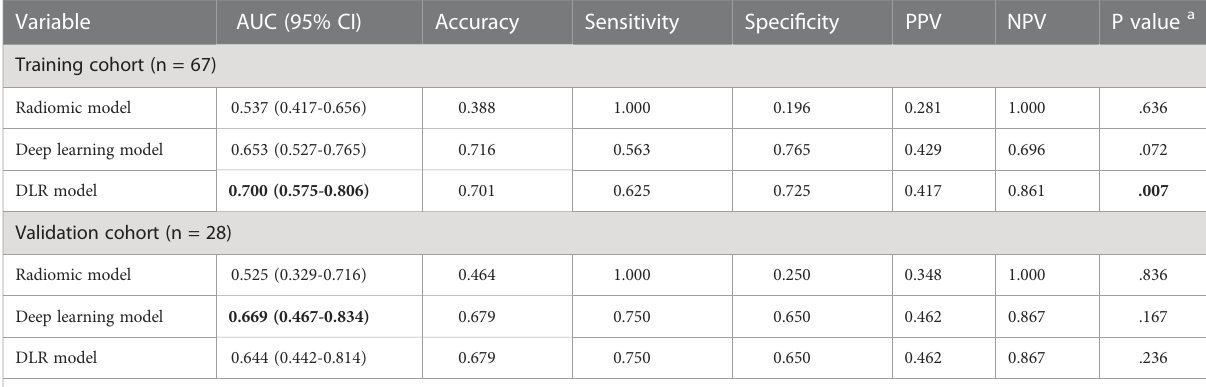
TABLE 2 Performance of pre-treatment image-based radiomics, deep learning and DLR